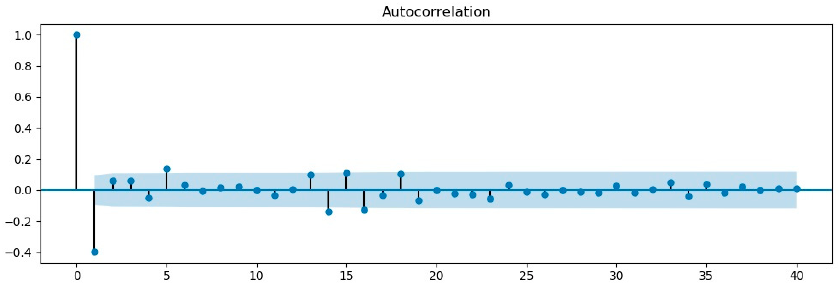
Figure 6. ACF diagram after first difference.